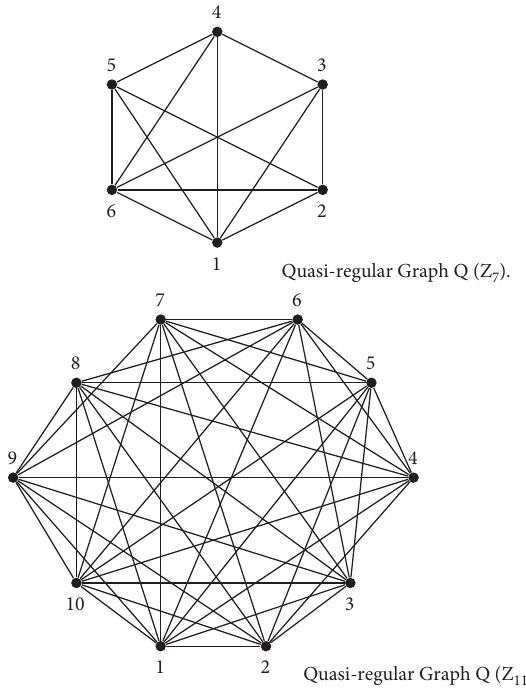
Figure 9: Number of edges of Q ( Z ) and Q ( Z ) . 11 11 drawn in Figure 7. In Figure 6, The quasiregular graph of ring Z is the case if di am � 1 . If the quasiregular graph is 3 ) then di am � 2 as drawn in complete, for example, Q ( Z 4 Figure 7. Finally; diam � 3 as shown in the graph of ring Z 6 ) in Figure 2. is drawn Q ( Z 6